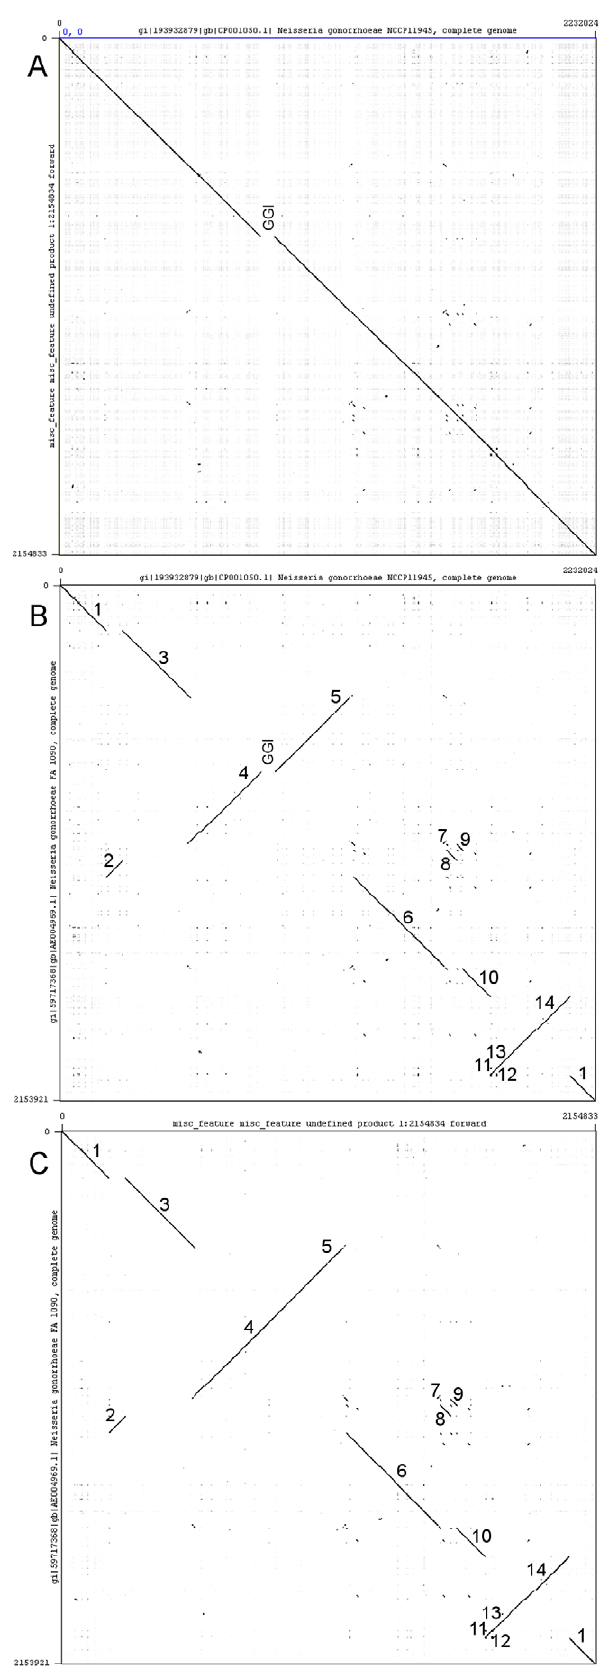
Figure 2. Dot plot alignments of the genome sequences of N.gonorrhoeae strains NCCP11945, TCDC-NG08107, and FA1090. Panel A: alignment of the complete genome sequence of strain NCCP11945 (horizontal) against TCDC-NG08107 (vertical); Panel B: alignment of the complete genome sequence of strain NCCP11945 (horizontal) against FA1090 (vertical); Panel C: alignment of the complete genome sequence of strain TCDC-NG08107 (horizontal) against FA1090 (vertical). The Gonococcal Genetic Island (GGI), present in strain NCCP11945, is indicated in panels A and B. For panels B and C, block numbers from Figure 1 are indicated. Reverse slopes indicate inversions of sequence between the two genomes being